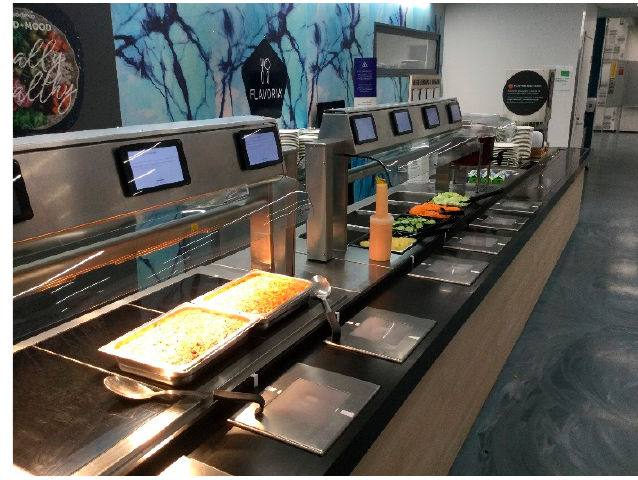
Figure 1. View of the buffet line.